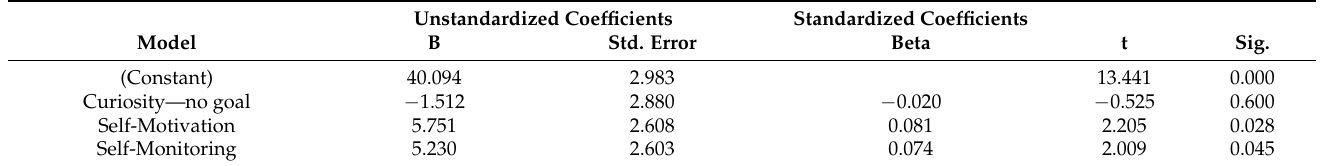
Table 3. Multiple regression to test the influences of egoistic motives for engaging in health self- tracking on the probability to donate.